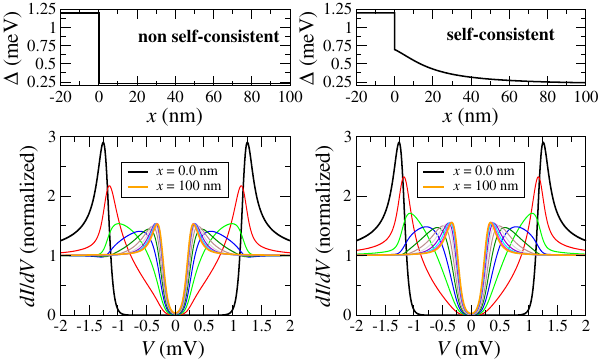
FIG. 8. The same as in Fig. 7, but for T ¼ 2 . 05 K. At this temperature, the monolayer is in its normal state. Notice that the order parameter determined self-consistently exhibits a finite value in the vicinity of the island.